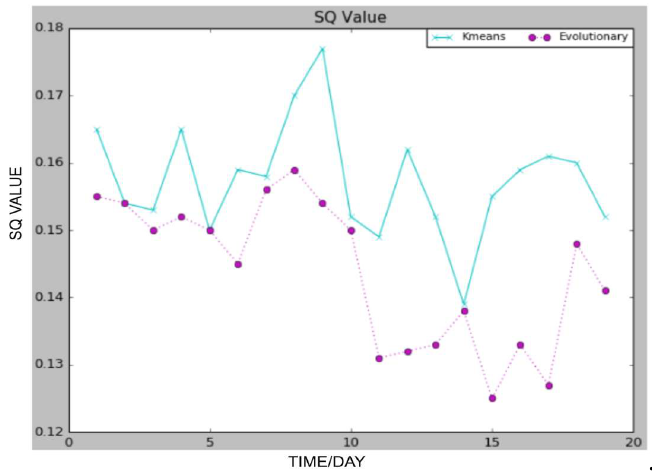
Figure 7. Nineteen days’ snapshot quality of K-means and evolutionary K-means in Shanghai dataset.